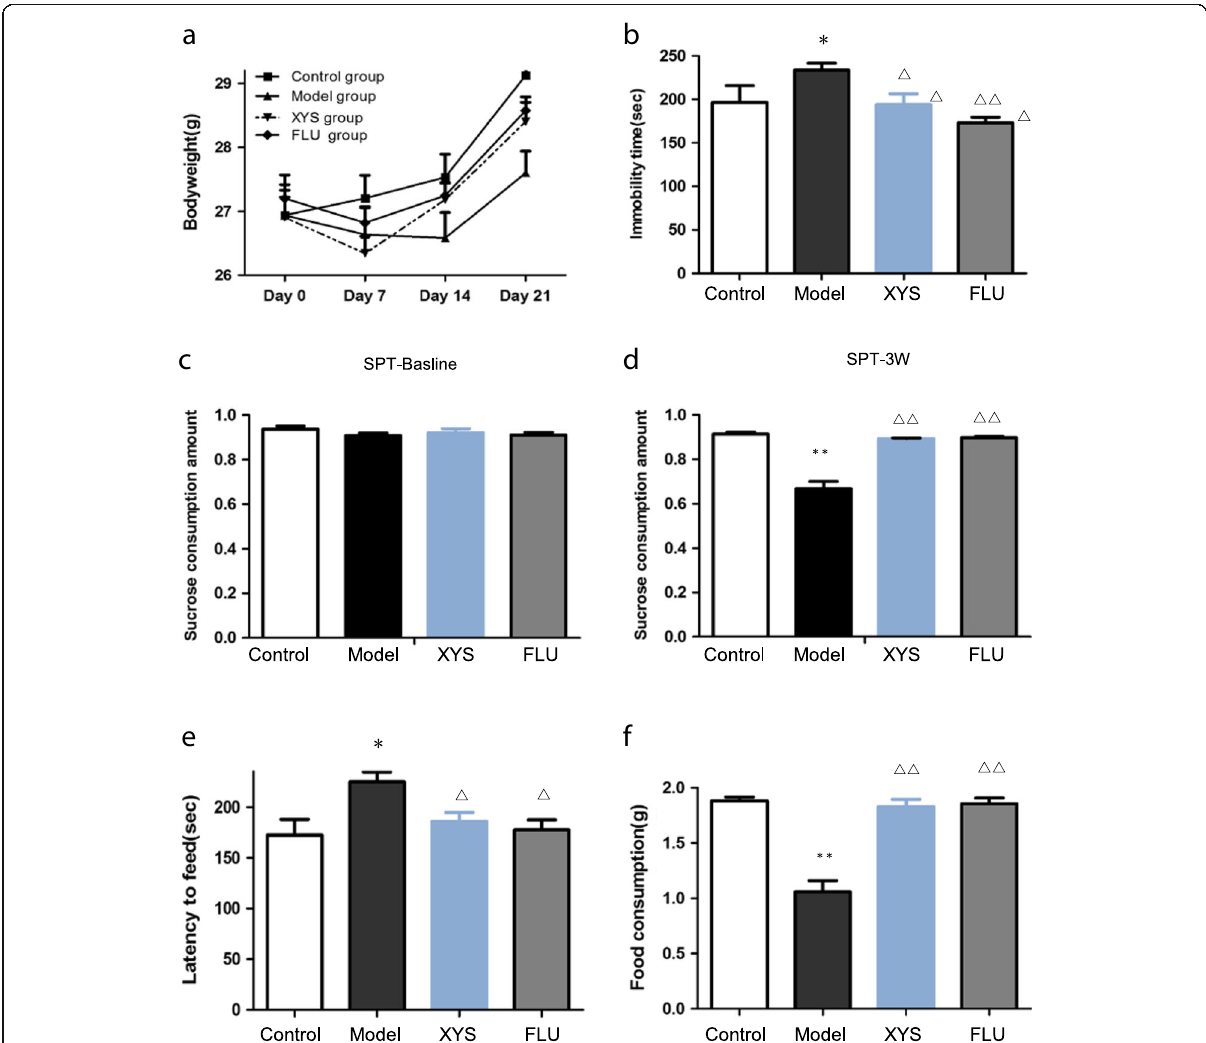
Fig. 3 Effects of XYS on body weight and behaviors in mice with CUMS. a Body weight was recorded once a week during 21d – CIS period. b The forced swimming test(FST) was conduct on day 21. c , d Sucrose preference test(SPT) was performed weekly. e , f The Novelty suppressed feeding (NSF) test was performed on day 21. Data were expressed as mean ± S.E.M, n = 15 per group. ∗ P < 0.05, ∗∗ p < 0.001 vs. control; △ p < 0.05, △△ p < 0.001 vs.